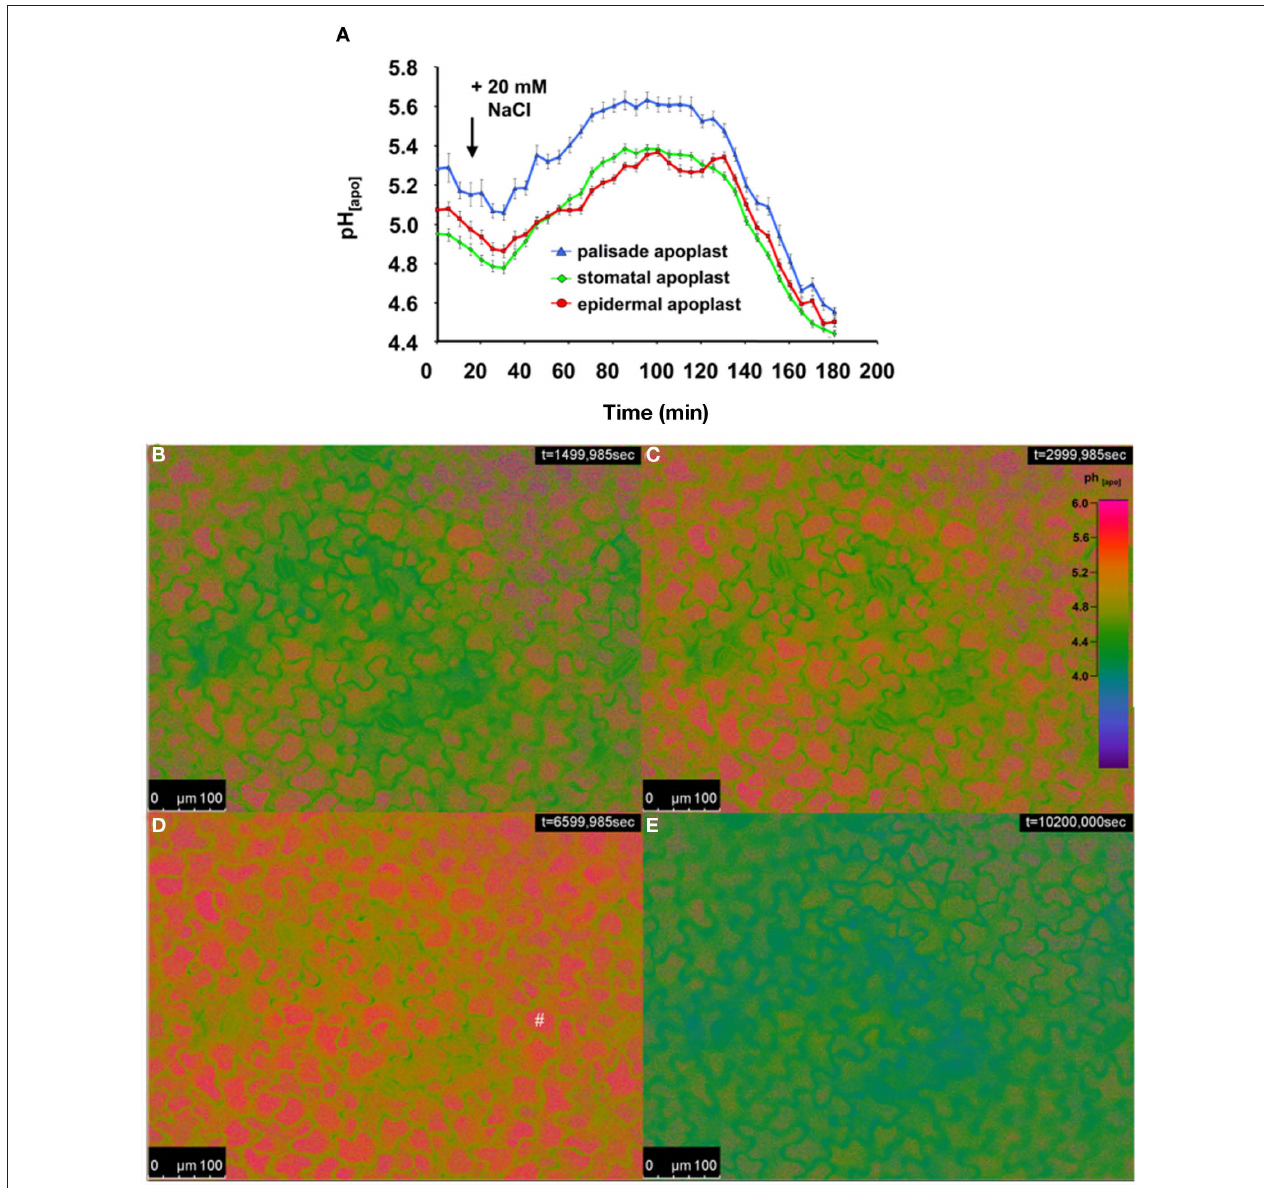
Figure 5 | ratiometric real-time quantitation of spatial leaf apoplastic pH gradients in response to 20 mM NaCl stress added to the roots. (A) Leaf apoplastic pH response was discriminated within three apoplastic components, viz. in the stomatal cavitiy ( n = 9 ROI; green kinetic; mean ± SE of ROIs), in the epidermal apoplast ( n = 20 ROI; red kinetic; mean ± SE of ROIs) and in the apoplast surrounding the palisade mesophyll ( n = 20 ROI; blue kinetic; mean ± SE of ROIs). Black arrow indicates the time of the addition of the 20 mM NaCl stress stimulus into the nutrient solution. Ratiometric images (B–e) show